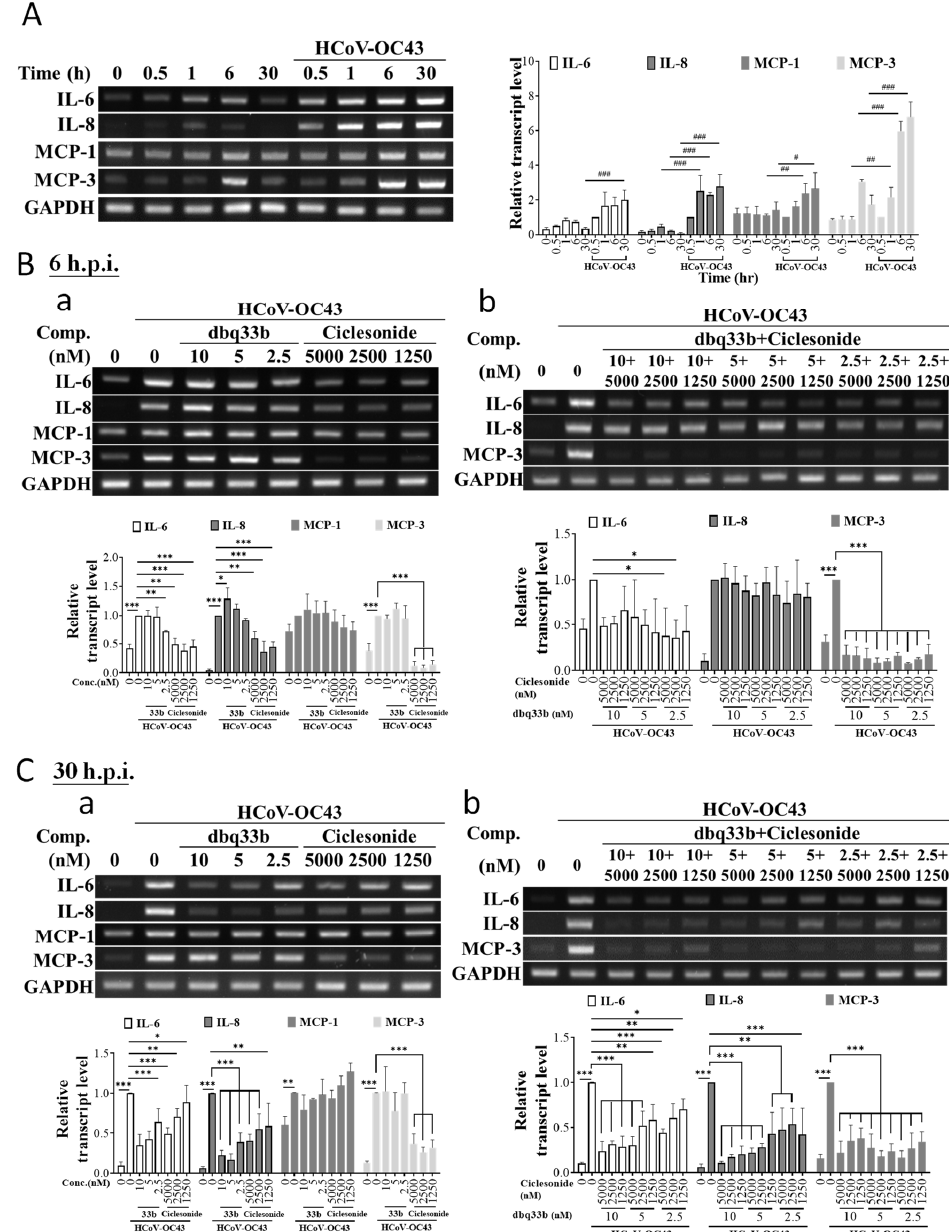
Figure 5. The effects of ciclesonide and tylophorine-based dbq33b alone or in combination on the transcriptional levels of cytokines induced by HCoV-OC43 in MRC-5 cells. ( A ) Transcriptions of cytokines, MCP-3, IL-8, IL-6, and MCP-1, were highly up-regulated in HCoV-OC43 in MRC-5 cells. ( B ) The effects of ciclesonide and tylophorine-based dbq33b, respectively ( Ba ), or in combination ( Bb ) on the up-regulated transcriptions of cytokines IL-6, IL-8, MCP-1, and MCP-3 at 6 h.p.i. ( C ). The effects of ciclesonide and tylophorine-based dbq33b respectively ( Ca ), or in combination ( Cb ) on the up-regulated transcriptions of cytokines IL-6, IL-8, MCP-1, and, MCP-3 at 30 h.p.i. The cells, in HCoV-OC43-infected MRC-5 (0.05 MOI) at 6 or 30 h.p.i. treated with vehicle (0.5% DMSO) or compounds as indicated, were subjected to TRIzol reagent for total RNA isolation and then RT-PCR for analysis of gene transcriptional expression of MCP-3, IL-8, IL-6, and MCP-1. Results shown are representative of three independent experiments and AVE ± S.D. from three independent experiments. (* p < 0.05, ** p < 0.01, *** p < 0.001 for student’s t -test; # p < 0.05, ## p < 0.01, ### p < 0.001 for two-way ANOVA